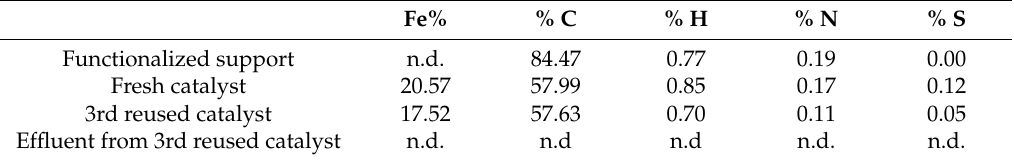
Table 2. Elemental analysis of the functionalized support and the catalyst (fresh and third